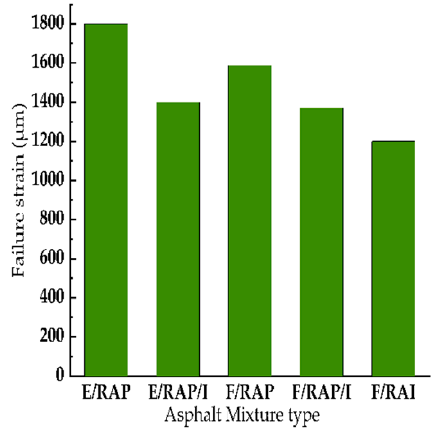
Figure 10. Low temperature bending test results of different CRMs.